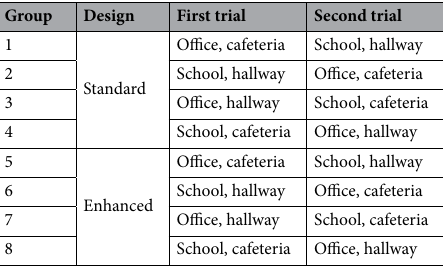
Table 2. Experiment